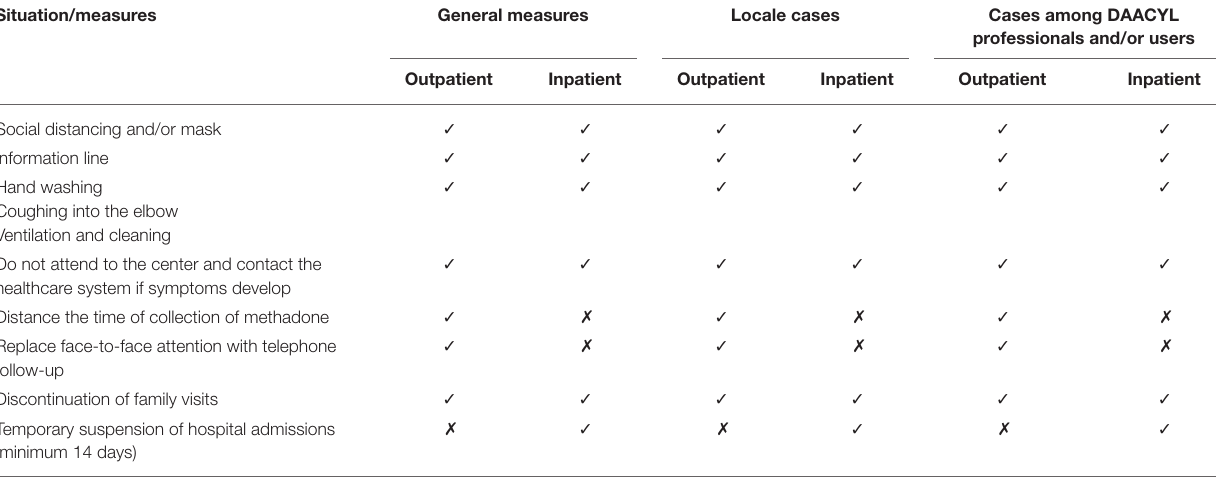
TABLE 4 | Action proposals in